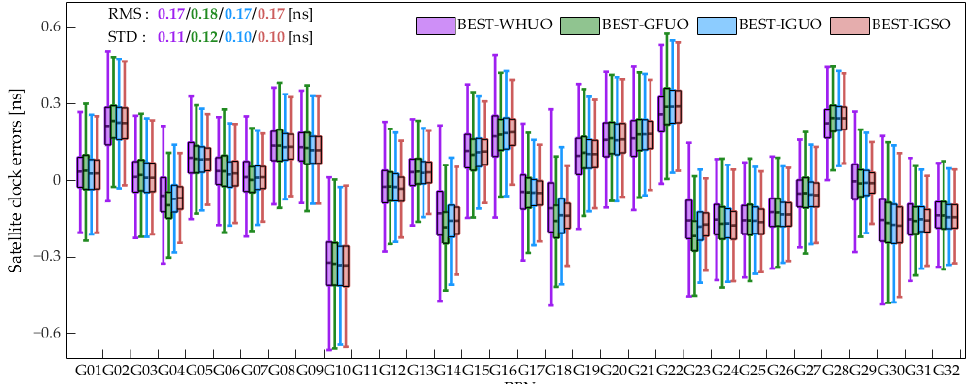
Figure 4. Batch-estimated satellite clock errors based on fixed WHUO, GFUO, IGUO and IGSO for one year.